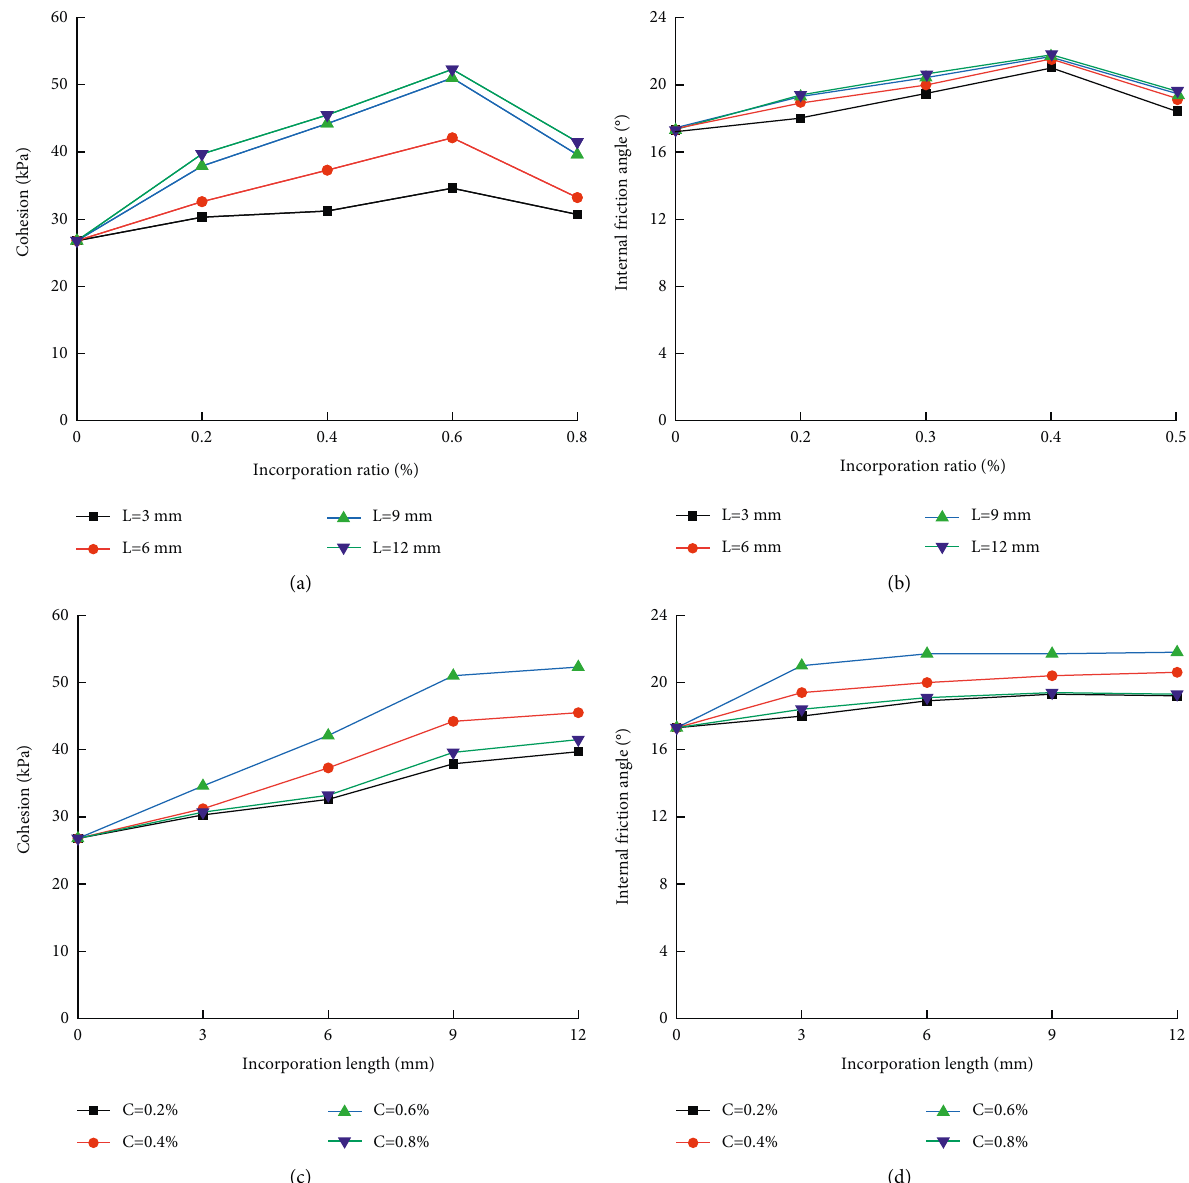
Figure 9: Changes in cohesion and internal friction angle with different fiber ratios and lengths (a) The relationship between different fiber rations and cohesion (b) The relationship between different fiber rations and angle of internal friction (c) The relationship between different fiber Lengths and cohesion (d) The relationship between different fiber lengths and angle of internal